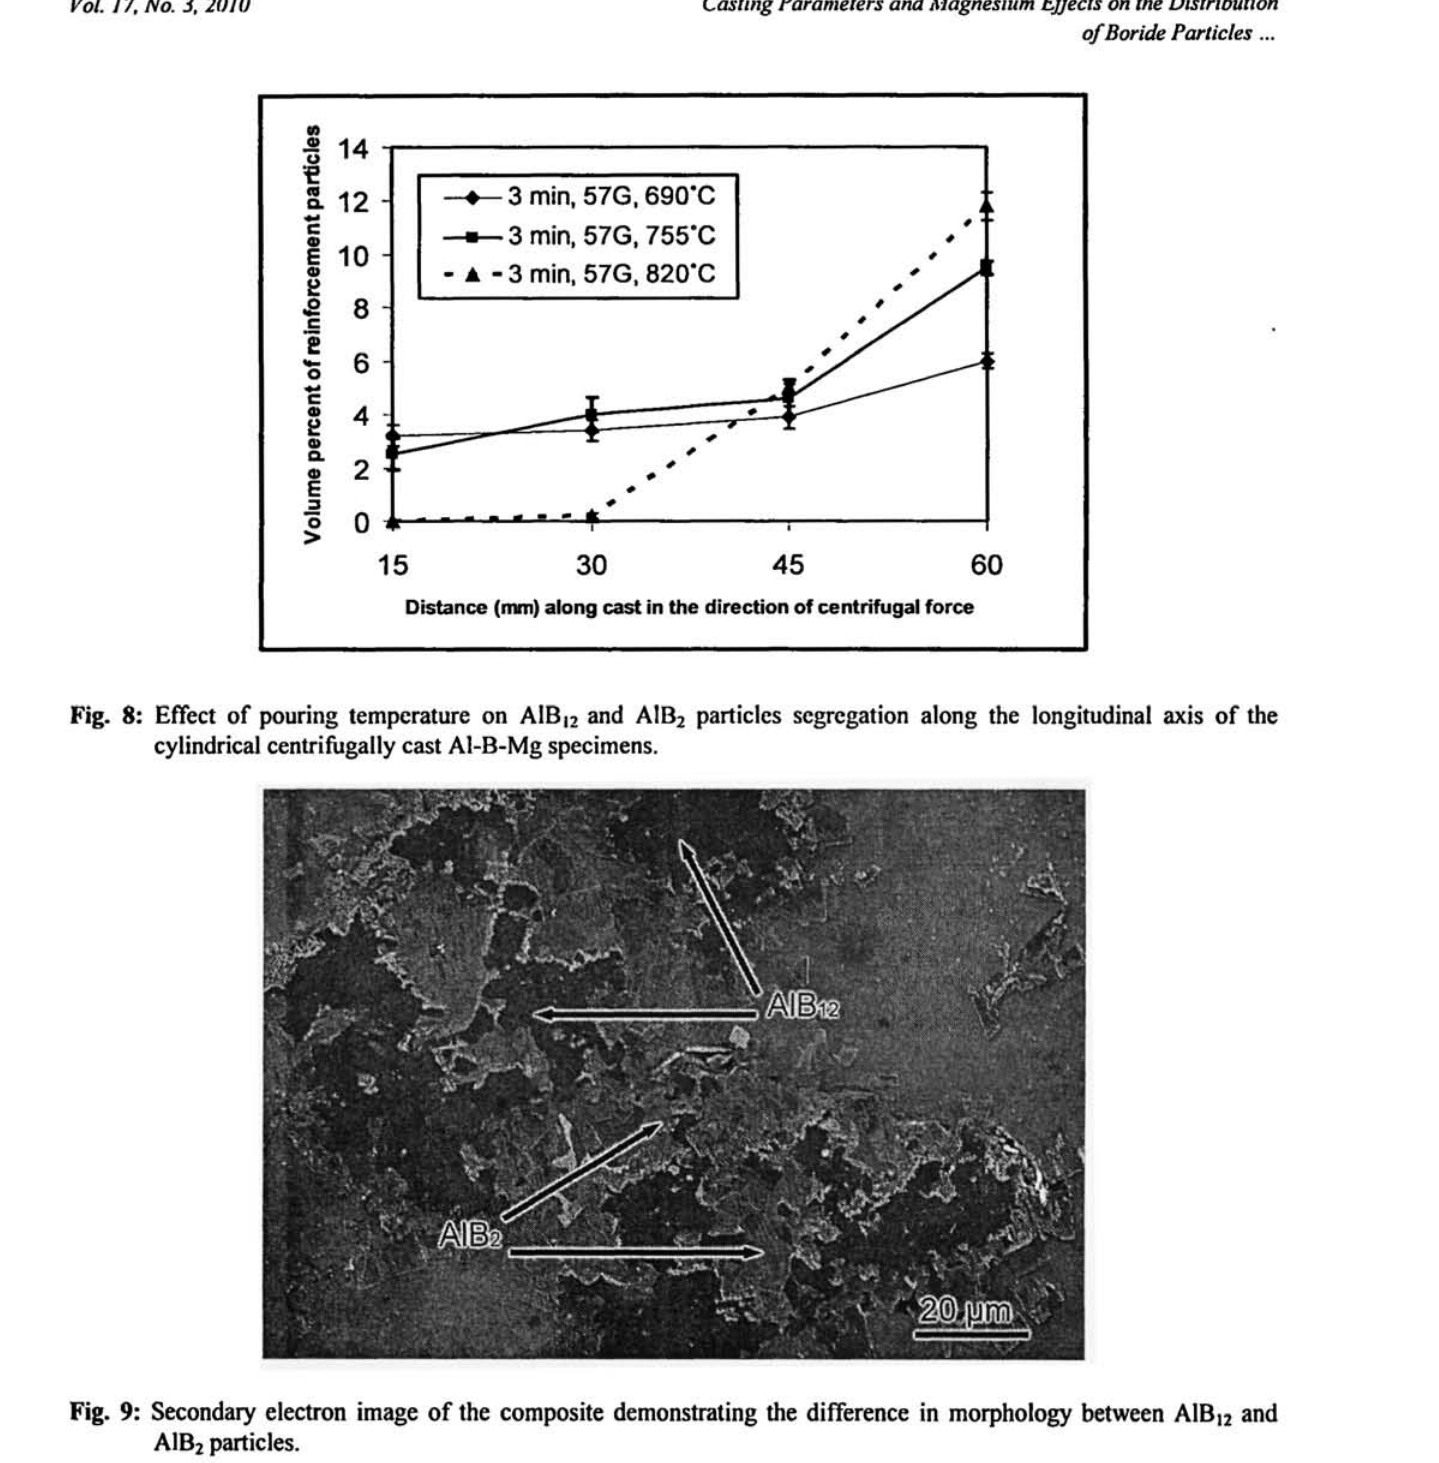
Fig. 9: Secondary electron image of the composite demonstrating the difference in morphology between A1B A1B 2